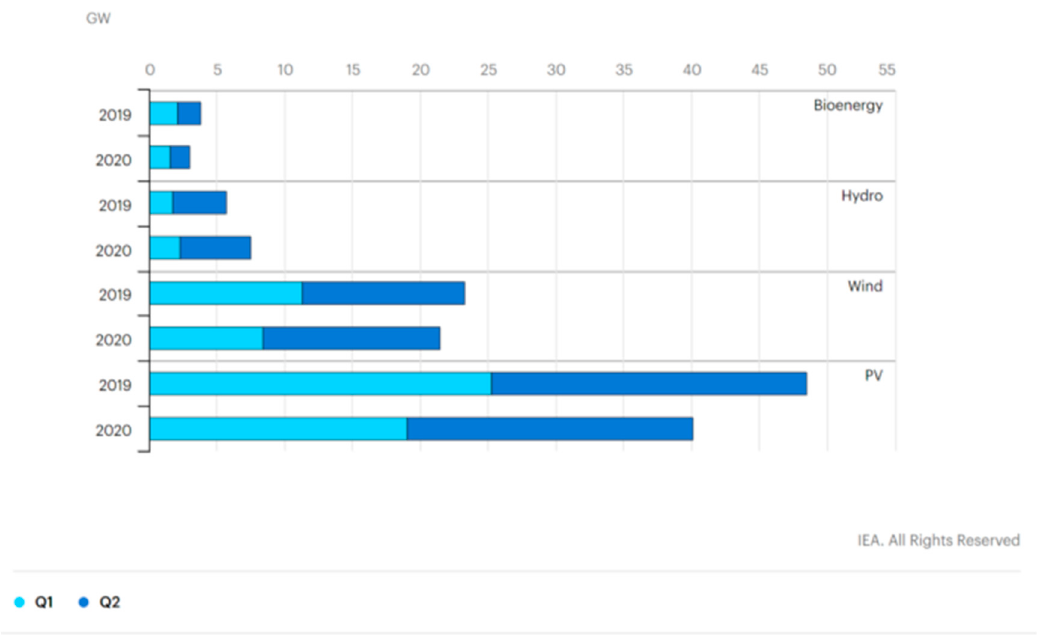
Figure 3. Energy expansion by energy source during the lockdown of 2019–2020 [13].